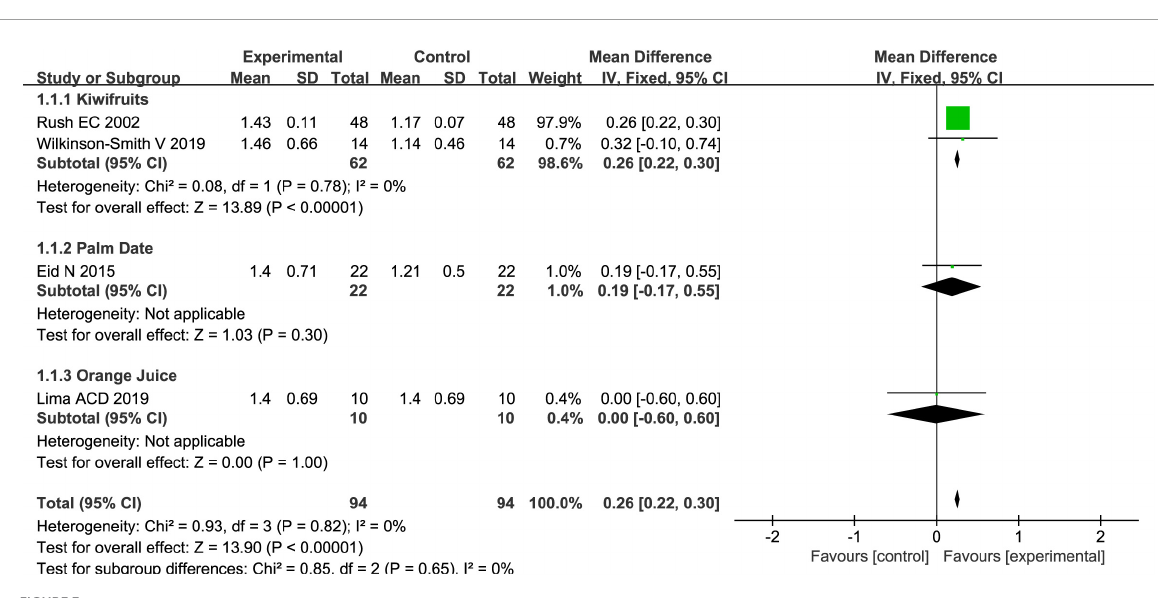
FIGURE3 Intervention effect of different types of fruits vs. placebo for stool frequency on patients in subgroup meta-analysis.